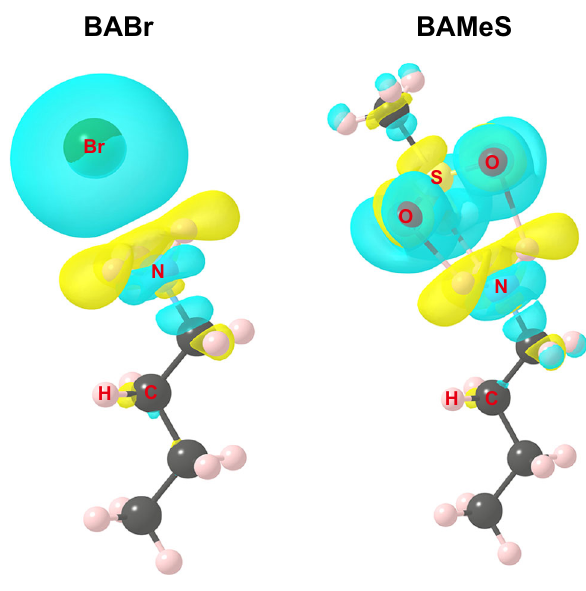
Fig. 2 Hydrogen bonding calculations. Differential charge density plots (isosurface value of 0.0015 eV Å − 3 ; cyan, charge accumulation; yellow, charge depletion) of BABr and BAMeS show that the bonding between BA and MeS induces more charge redistribution than that between BA and